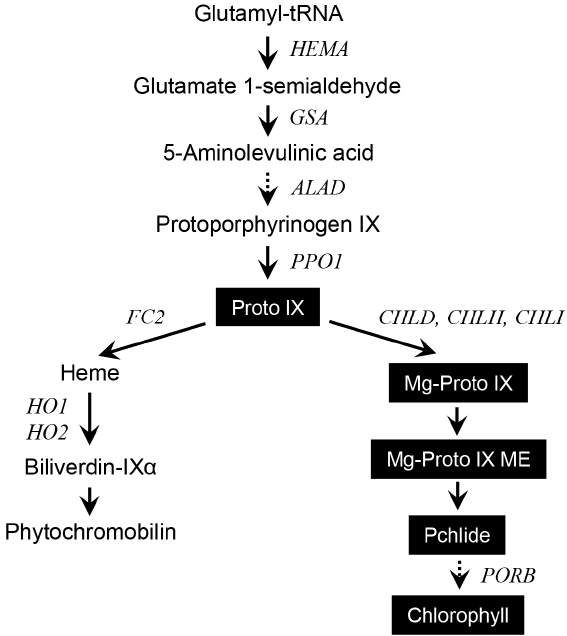
Figure 1. The porphyrin pathway in plants showing metabolites and genes analyzed in this study. Metabolites quantified in this study are highlighted. Proto IX, protoporphyrin IX; Mg-Proto IX, Mg-protoporphyrin IX; Mg-Proto IX ME, Mg-protoporphyrin IX monomethyl ester; Pchlide, protochlorophyllide. Genes and enzymes that correspond to the gene names: HEMA , glutamyl-tRNA reductase; GSA , glutamate 1-semialdehyde aminotransferase; ALAD , ALA dehydratase; PPO , protoporphyrinogen oxidase; FC2 , Fe-chelatase 2; HO , heme oxygenase; CHLD , D -subunit of Mg-chelatase; CHLH , H-subunit of Mg-chelatase; CHLI , I-subunit of Mg-chelatase; PORB , protochlorophyllide oxidoreductase B. Solid and dashed arrows indicate a single step and multiple steps, respectively.